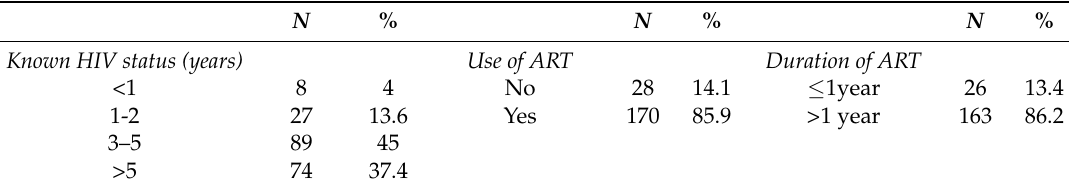
Table A2. Characteristics of HIV status.